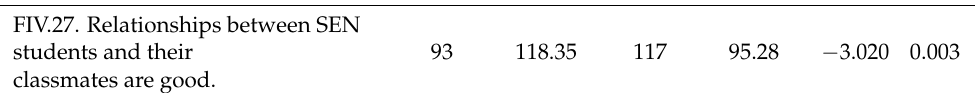
Table 8. Mann–Whitney U analysis to compare results according to gender. Male Female Variable N Rank N Rank FI. University accessibility and